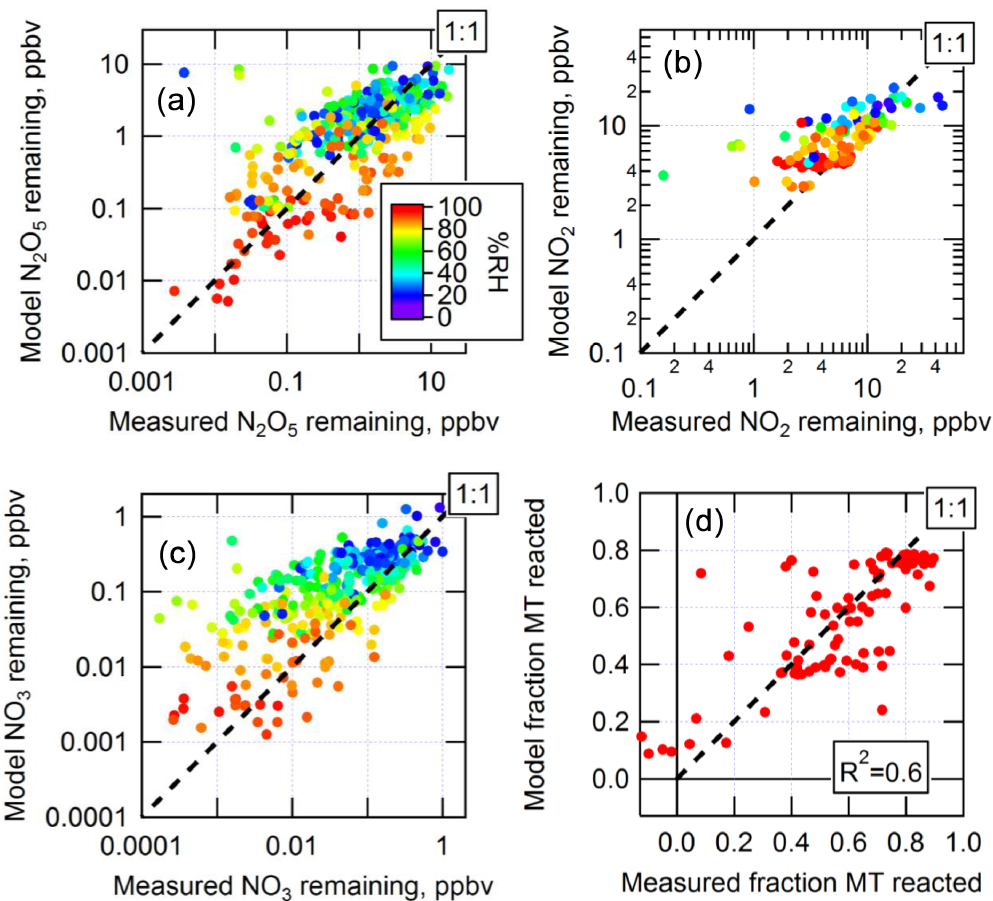
Figure 2. Modeled vs. measured (a) N 2 O 5 , (b) NO 2 , (c) NO 3 , and (d) fraction of ambient MT reacted with NO 3 in the output of the NO 3 -OFR.